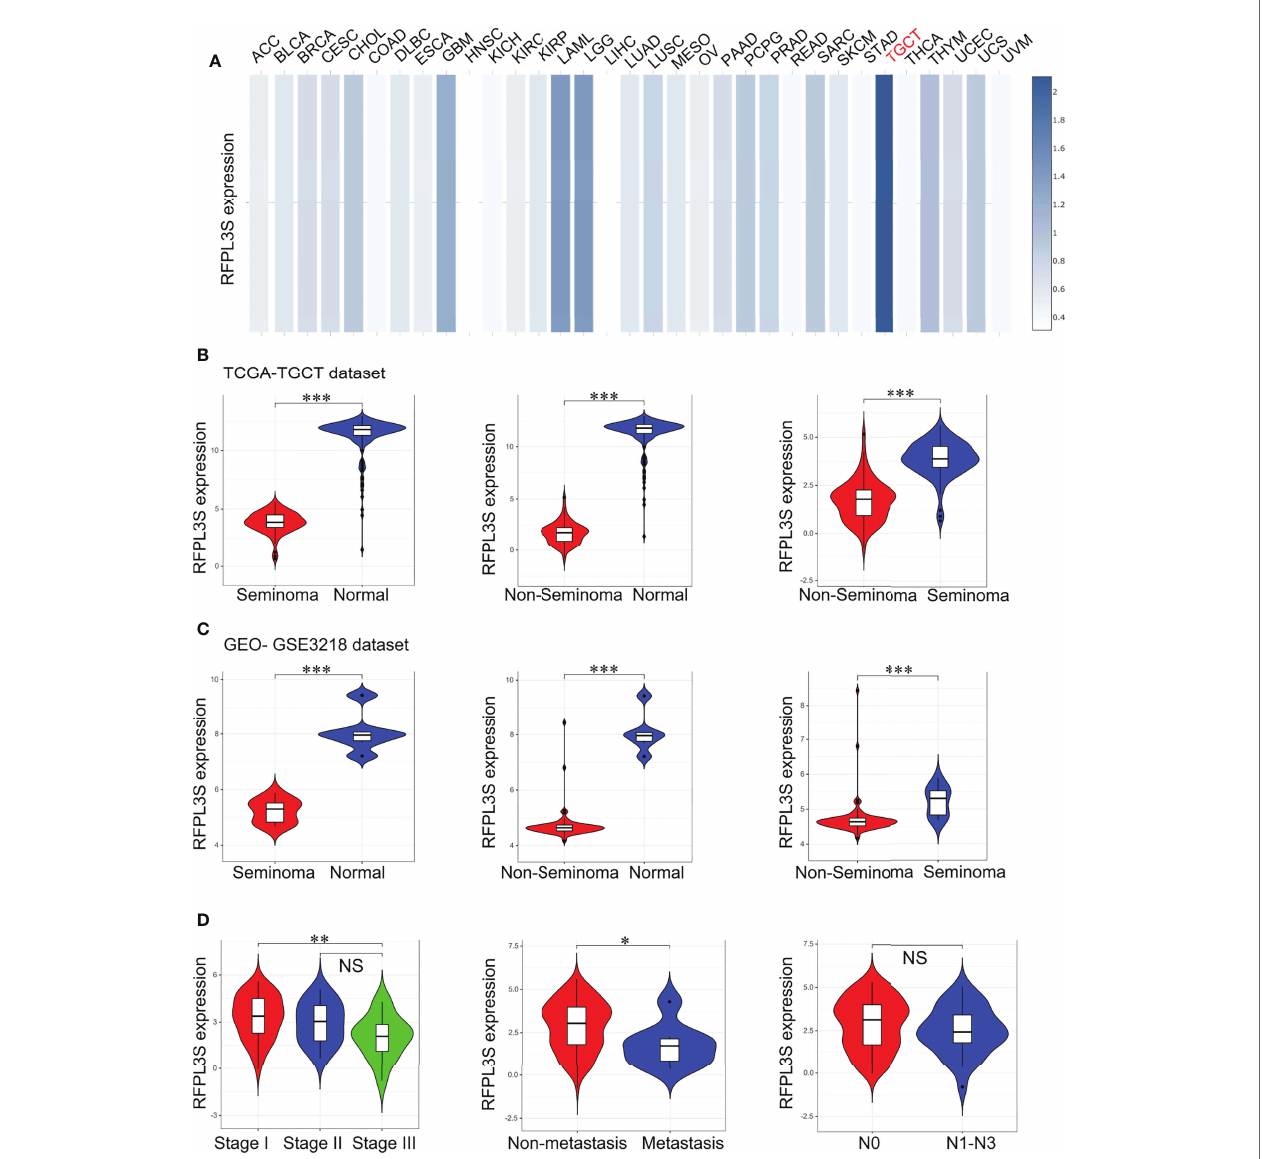
FIGURE 1 | The association between RFPL3S and the clinicopathological characteristics of TGCT. (A) GEPIA2 online tool was used to analyze the expression of RFPL3S in various tumors. RFPL3S was highest expressed in TGCT (indicated by red color). (B) Analysis for the expression of RFPL3S in seminoma, non- seminoma, and normal tissues in TGCT cohort from TCGA. (C) Analysis for the expression of RFPL3S in seminoma, non-seminoma, and normal tissues in GSE3218 cohort. (D) Analysis for the association of the expression of RFPL3S with the clinicopathological characteristics (clinical stage, distant metastasis, and lymph node metastasis) of TGCT from TCGA. The TCGA TGCT cohort data was downloaded from the UCSC XENA database (https://xena.ucsc.edu/). The GSE3218 data was downloaded from the GEO database. Visualizing and interpreting cancer genomics data via the Xena platform. *P < 0.05, **P < 0.01, ***P < 0.001. NS, no signi fi